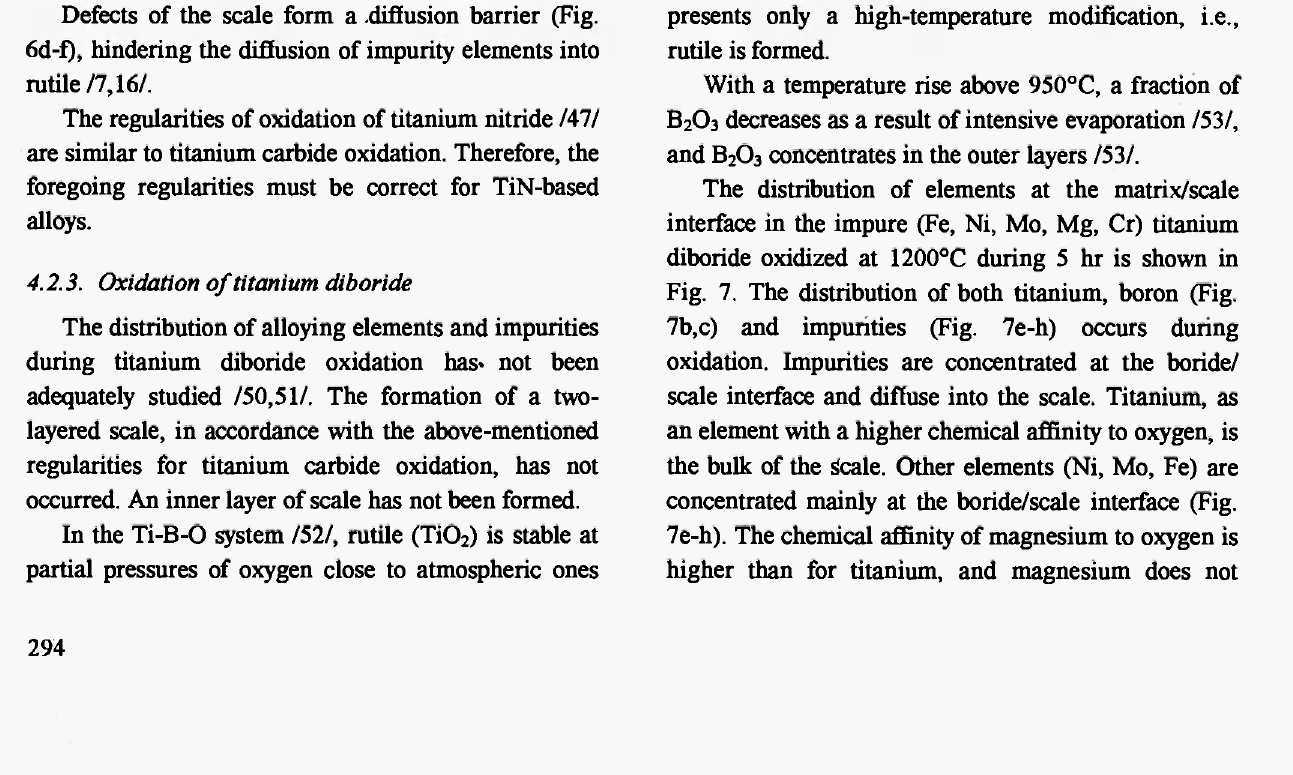
Fig. 5: Redistribution of Ti, Ni and Mo at the inner scale/outer scale interface in the TiC-Ni-Mo alloy; a - backscattered electrons; b - Ti K„; c - Ni K^ d - Mo K« -radiation. interface since higher values of oxygen partial pressure are necessary for its oxidation. Molybdenum and silicon with higher values of (AG) as compared to nickel, iron and cobalt, but with a lower diffusion mobility, were not found in the rutile of the outer scale. Defects of the scale form a diffusion barrier (Fig. rutile Π,